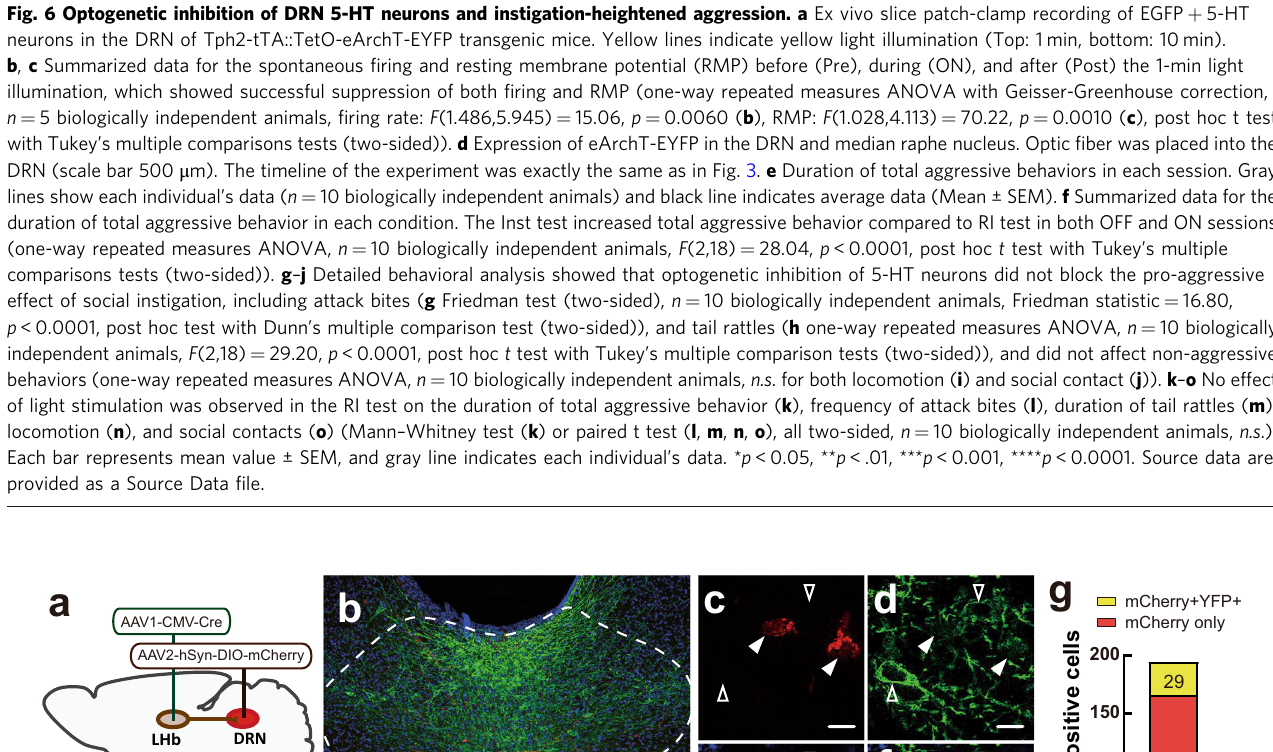
Fig. 6 Optogenetic inhibition of DRN 5-HT neurons and instigation-heightened aggression. a Ex vivo slice patch-clamp recording of EGFP + 5-HT neurons in the DRN of Tph2-tTA::TetO-eArchT-EYFP transgenic mice. Yellow lines indicate yellow light illumination (Top: 1 min, bottom: 10 min). b , c Summarized data for the spontaneous fi ring and resting membrane potential (RMP) before (Pre), during (ON), and after (Post) the 1-min light illumination, which showed successful suppression of both fi ring and RMP (one-way repeated measures ANOVA with Geisser-Greenhouse correction, n = 5 biologically independent animals, fi ring rate: F (1.486,5.945) = 15.06, p = 0.0060 ( b ), RMP: F (1.028,4.113) = 70.22, p = 0.0010 ( c ), post hoc t test